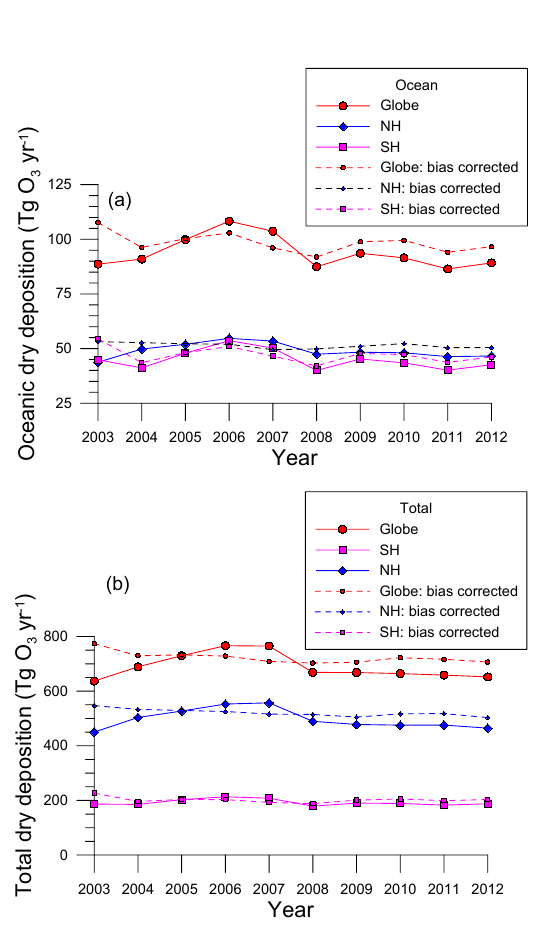
Figure 13. Scatter plot of annual averaged normalised median bias (%) in the MACC ozone reanalysis mixing ratios relative to the Global Atmosphere Watch (GAW) surface observations for the years 2003–2012 versus the total global deposition and total depo- sition to the ocean determined based on the MACC reanalysis. The best fit lines are also